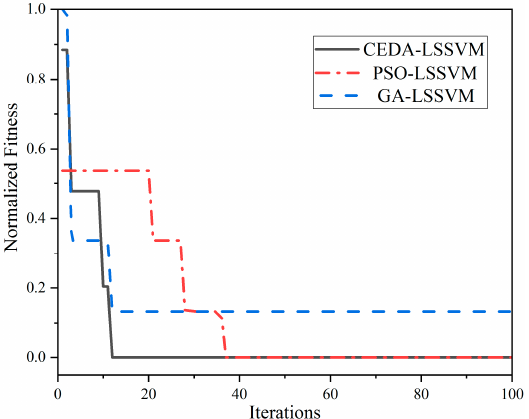
Figure 9. The comparison of the regression effect between CEDA-LSSVM and PSO-LSSVM and GA- LSSVM.